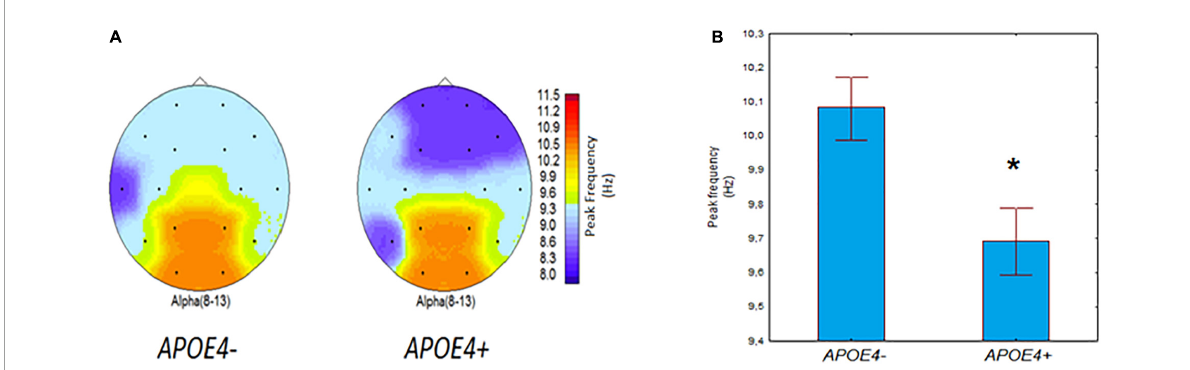
FIGURE1 EEG individual alpha peak frequency (IAPF) in non-demented APOE4– and APOE+ carriers. (A) Group-averaged EEG topographical plots of IAPF in individuals with APOE4+ and APOE4– genotypes. (B) IAPF (mean and SE) in individuals with APOE4+ and APOE4– genotypes. * p = 0.01; significant difference between APOE4+ vs. APOE4–